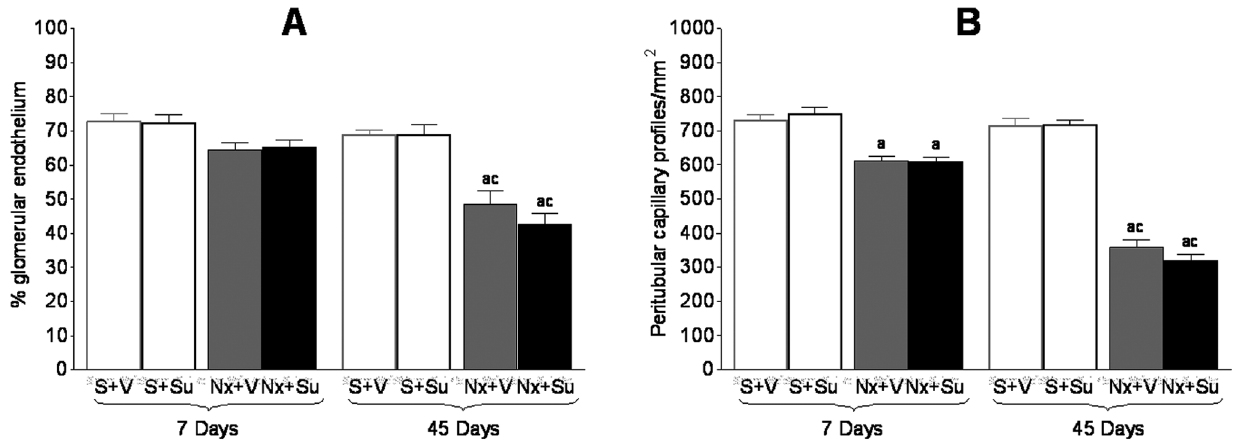
Figure 2. Vascular endothelial evaluation. A) % glomerular area occupied by endothelium; B) Number of peritubular capillary profiles. a p , 0.05 vs. respective S; b p , 0.05 vs. respective untreated; c p , 0.05 vs. respective value on Day 7.